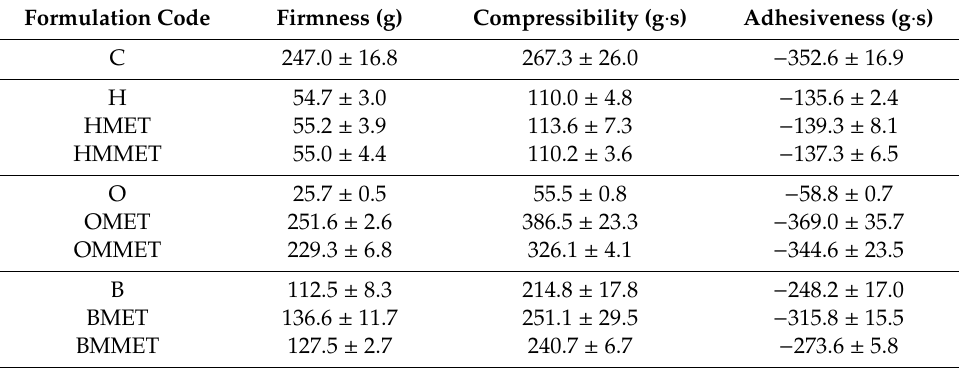
Table 4. Textural properties of bigels, hydrogels, oleogels containing MET (HMET, OMET, BMET)